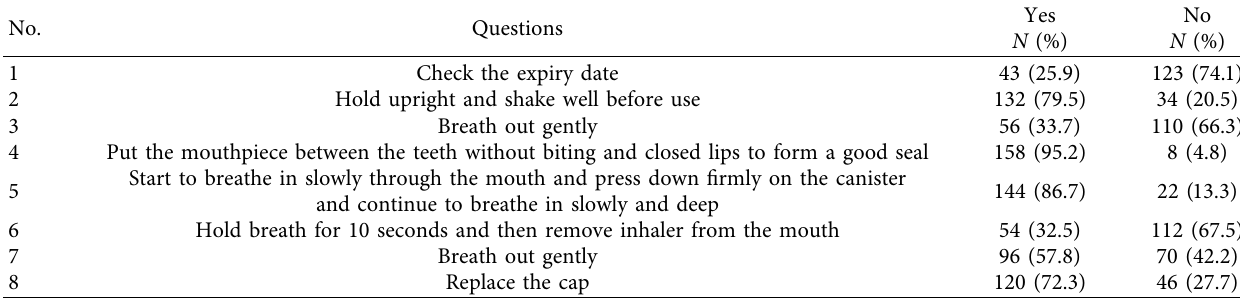
Table 3: Practice of inhaler uses within the respondents, DMCSH, 2020.